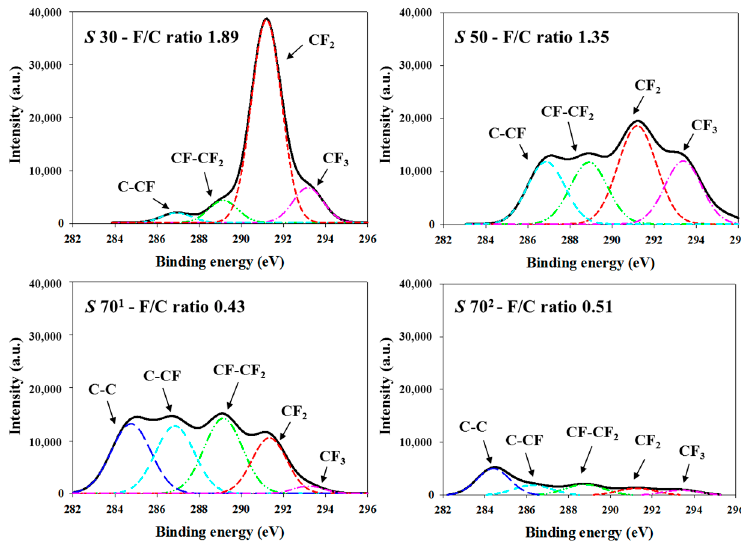
Figure 3. High resolution of C1s spectra and F/C ratio for the fluorinated surface on S 30, S 50, S 70 1 and S 70 2 substrates after plasma treatment.